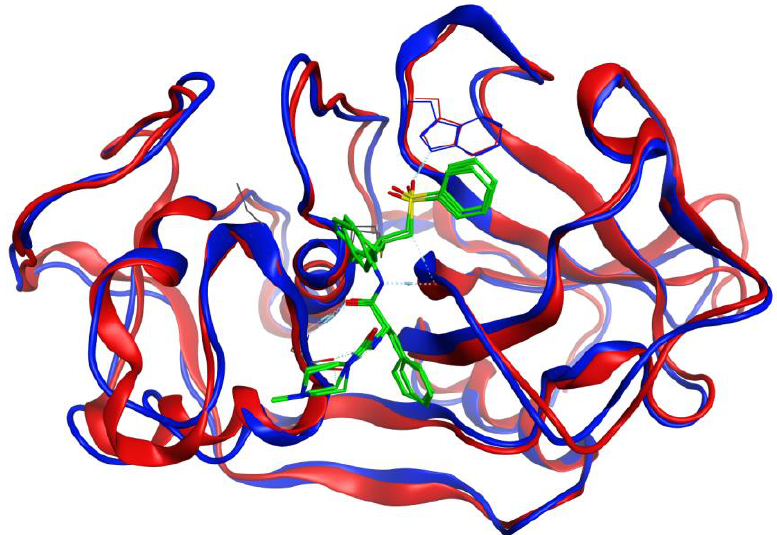
Figure 5. Overlay of the protein structures of human cathepsin V, PDB 1FH0 [26] (red ribbon), and the homology model of Trichomonas vaginalis cathepsin L-like protein, TvCPCAC1 (blue ribbon). The co-crystallized ligand is shown as a wireframe structure.